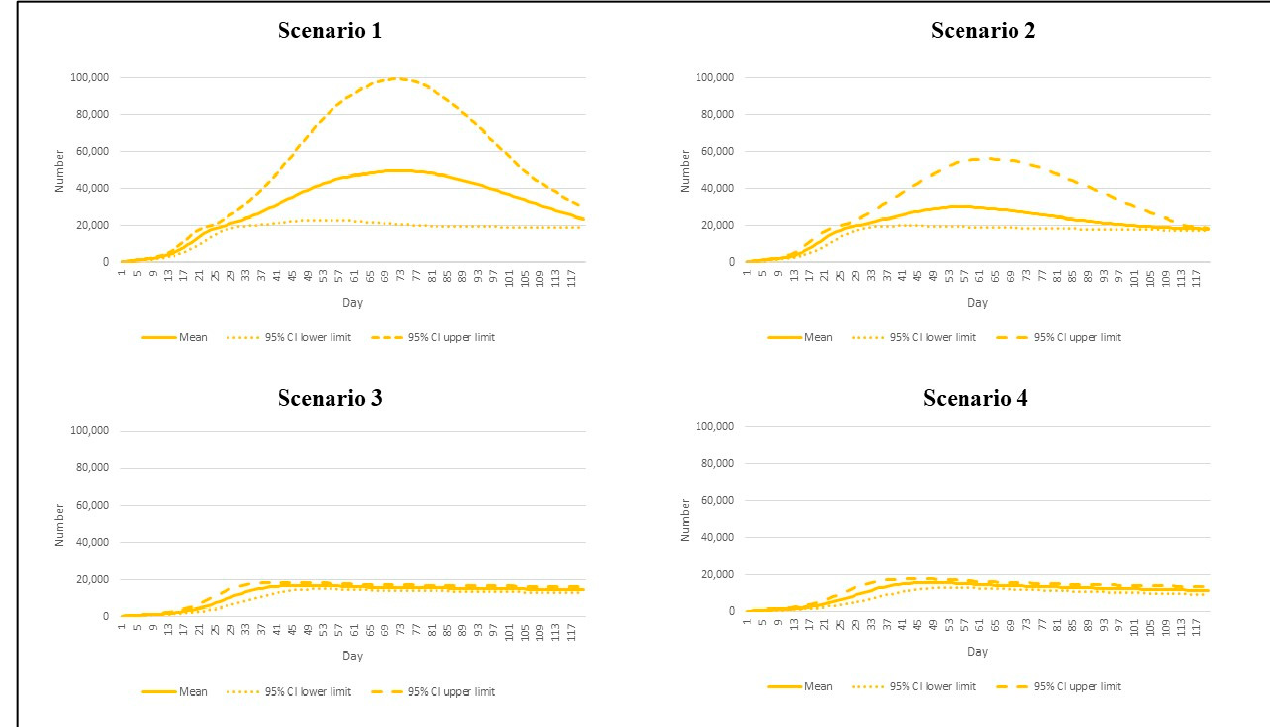
Figure 2. The daily incident cases by different epidemic scenarios.